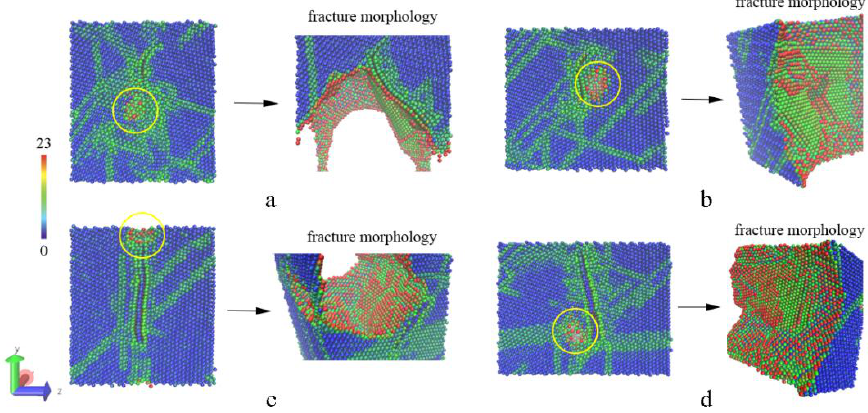
Figure 5. The atomic details of initial cracks and fracture surfaces. ( a , b ) The composite with SLG is stretched in Y and Z directions; ( c , d ) the composite with BLG is stretched in Y and Z directions. The stress–strain curves of models stretched in in-plane and normal directions are drawn in Figure 7. It should be noted that the inverse Hall–Petch relationship will lead to a drop in strength at this scale where metal grains have a size of less than 10